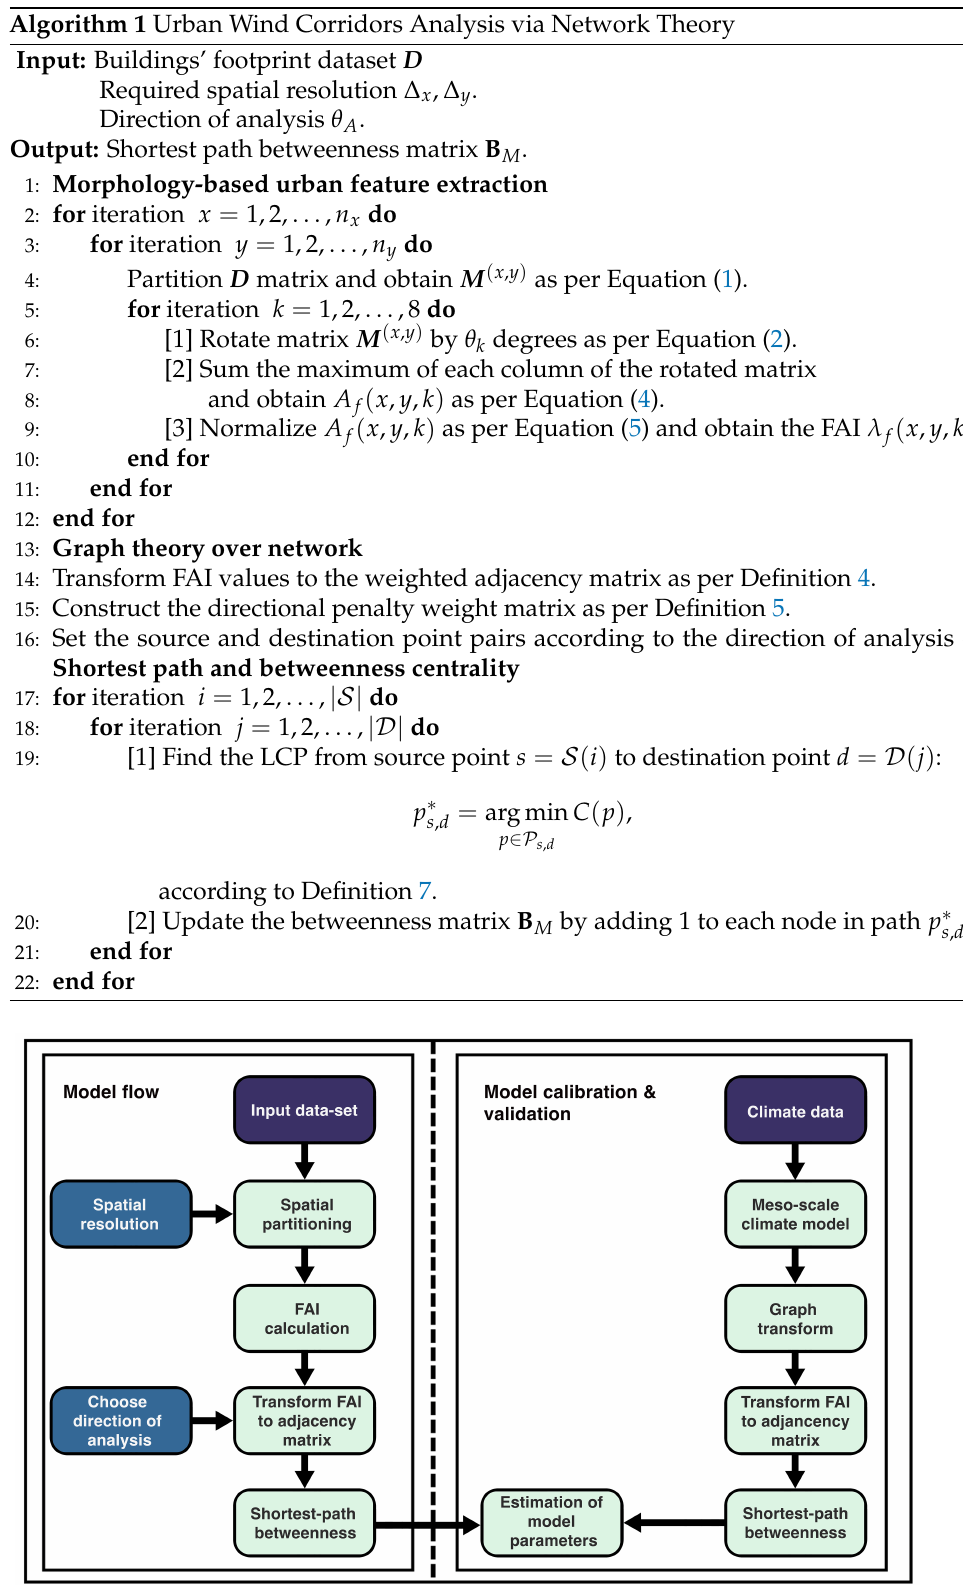
Figure 1. System model. Left panel : the proposed framework where the input is the 3D dataset of building heights and the user needs to choose the spatial resolution and the direction of analysis. Right panel : the calibration of the proposed model against a meso-scale climate